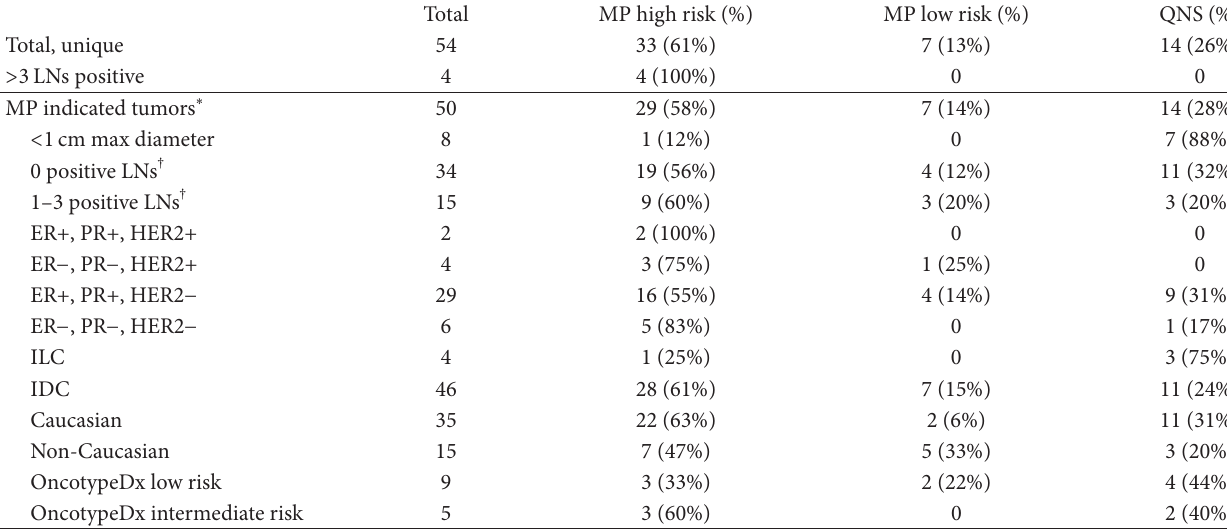
T 1: Summary of MammaPrint risk assessments.